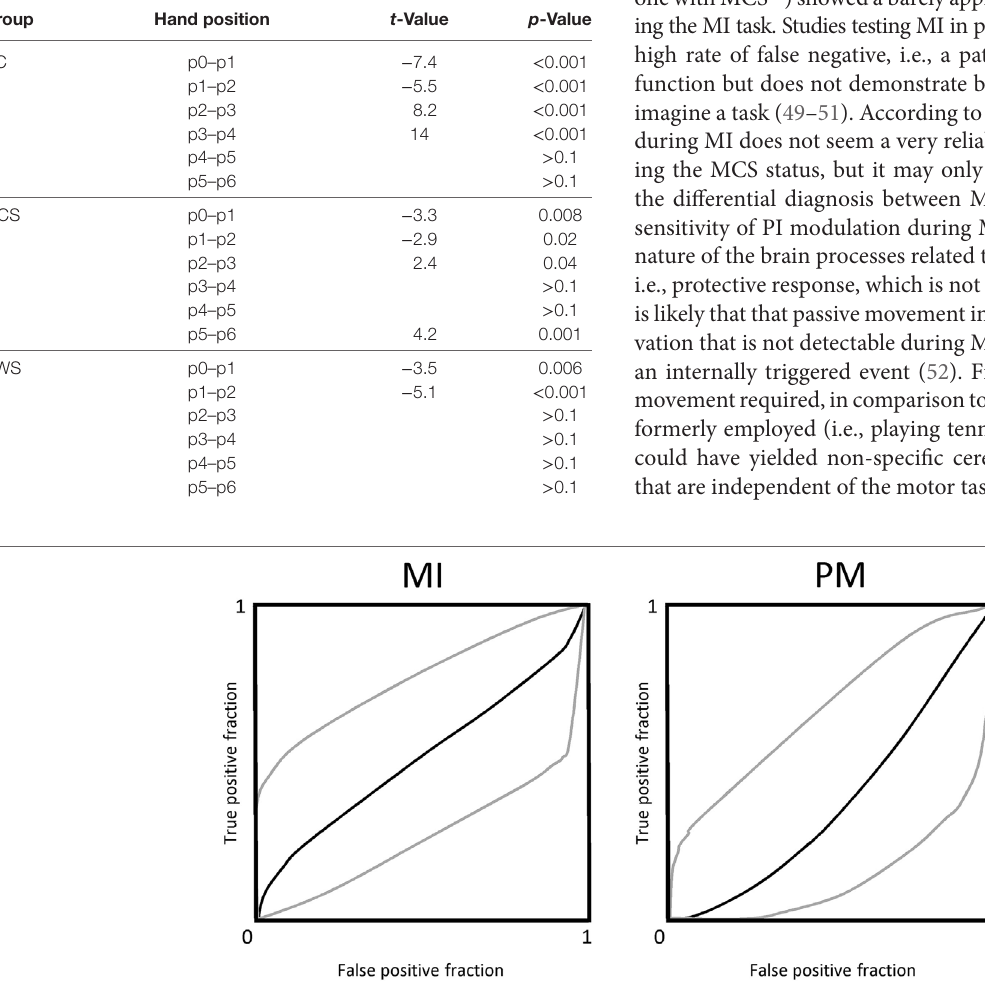
FigUre 7 | The power of motor task-induced cerebral blood flow velocity modulation across the hand-position employed in differentiating patients with disorders of consciousness is shown by the area under the receiver operating characteristic curve (AUC) for motor imagery (MI) and passive mobilization tasks.